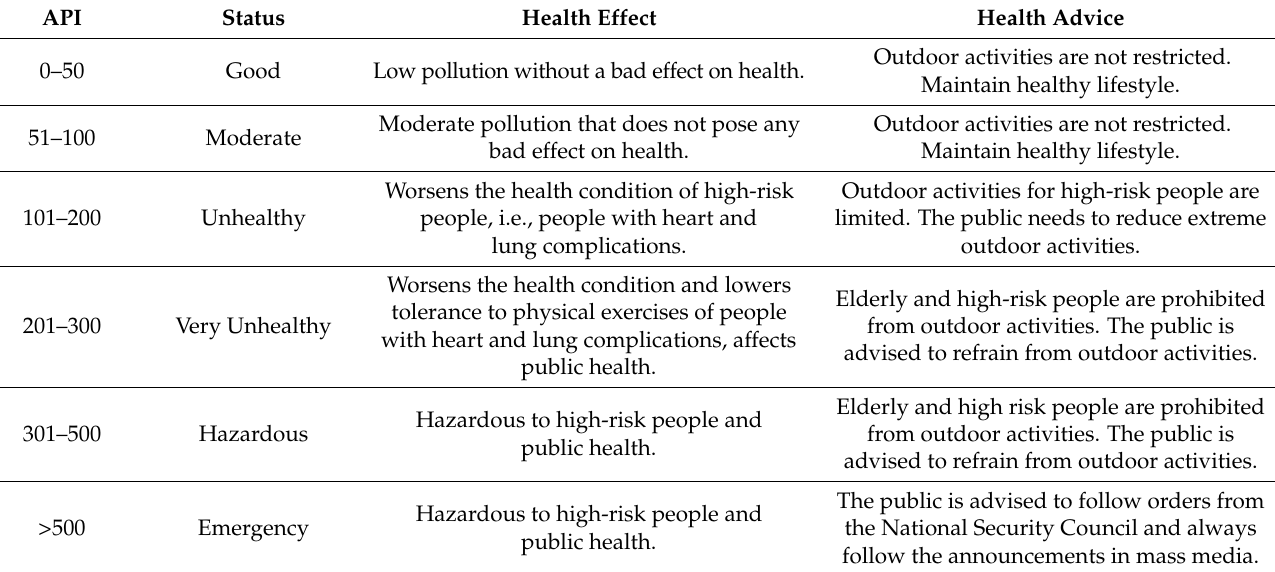
Table 1. API values and their corresponding health effects and